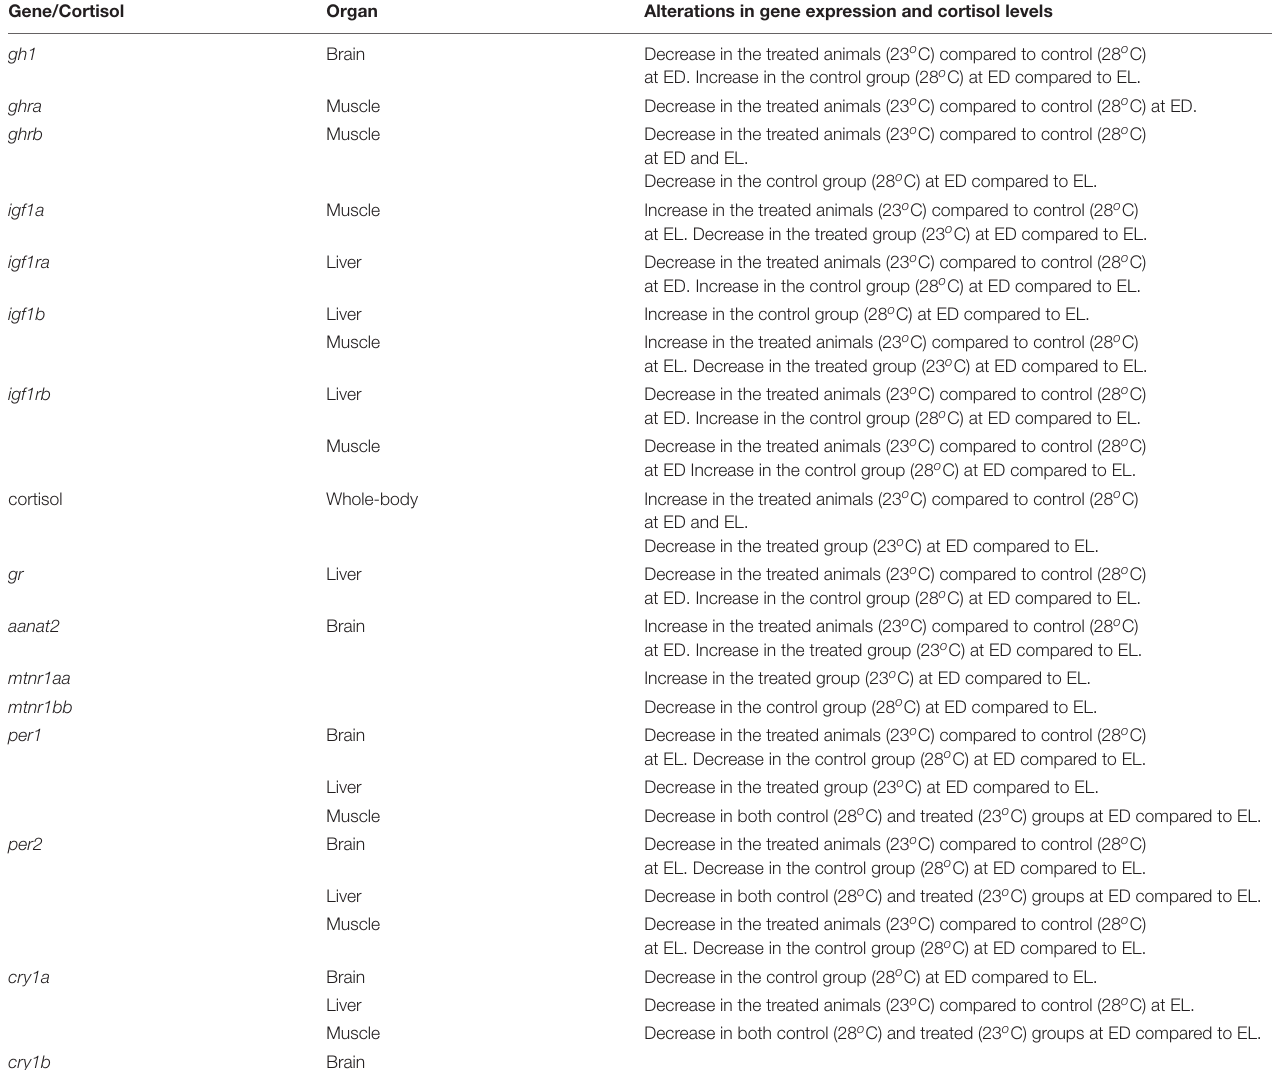
TABLE 2 | Overview of temperature or time point effect on hormonal pathways. Gene/Cortisol Organ Alterations in gene expression and cortisol levels